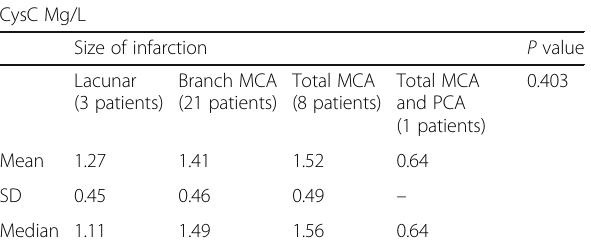
Table 2 Level of CysC according to size of infarction CysC Mg/L Size of infarction P